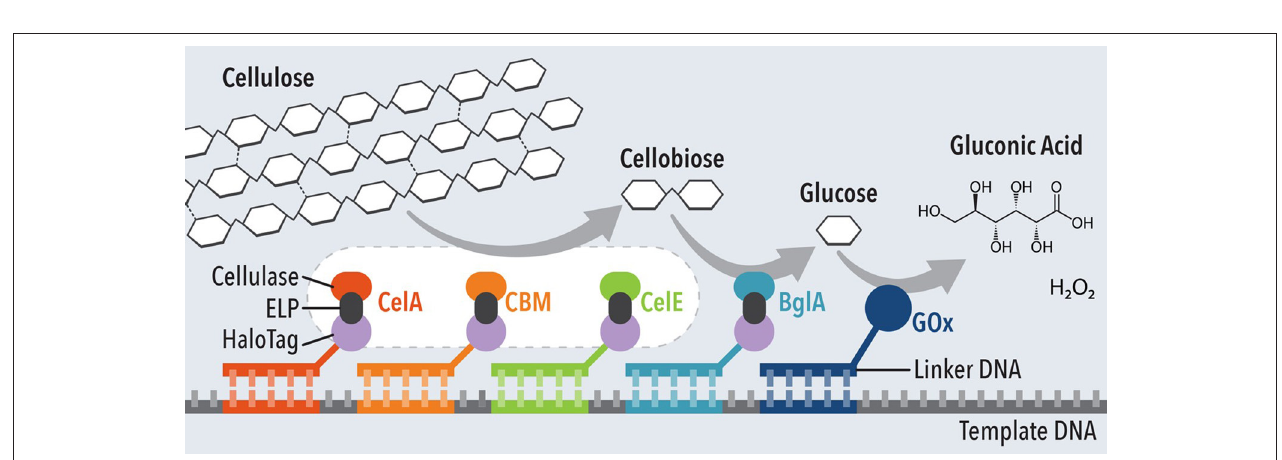
FIGURE 4 | Schematic of (A) fabrication of various GOx-functionalized electrodes and their mechanism of immobilization; (B) comparison between native GOx and GOx/PCA composite ( Christwardana et al., 2017).